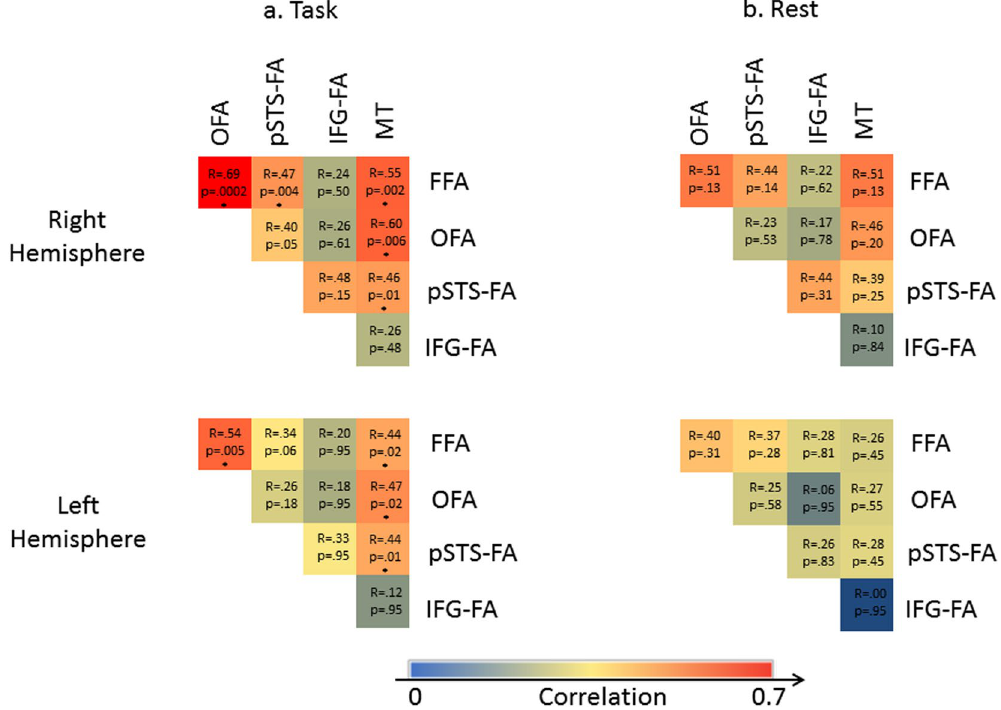
Figure 6. Functional connectivity of the face processing system during task ( a ) and rest ( b ) The color code indicates the level of correlation calculated between each pair of regions in each subject and then averaged across subjects. * p <